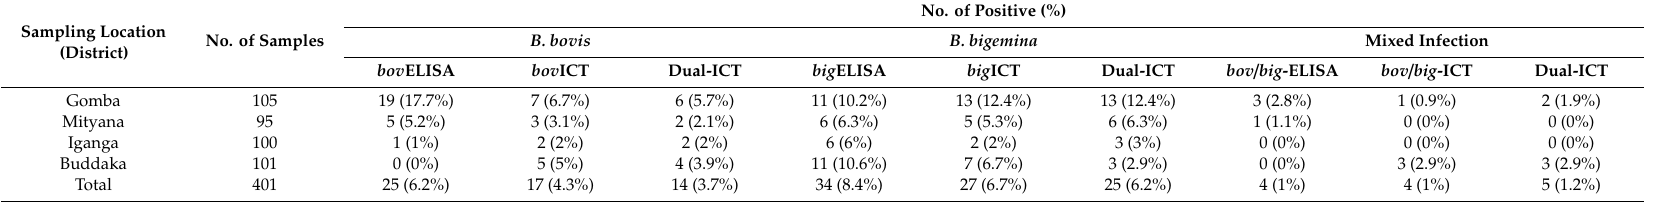
Table 2. The results of ELISA and ICTs of Babesia bigemina and Babesia bovis in all sampling sites from Uganda. Sampling Location